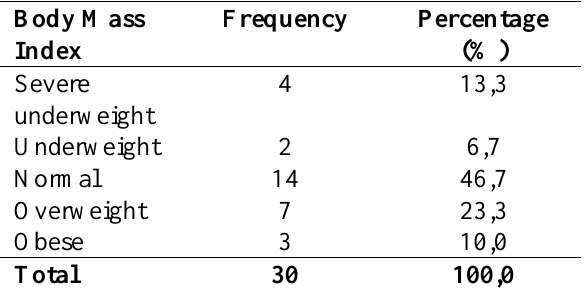
Table 3. Body Mass Index